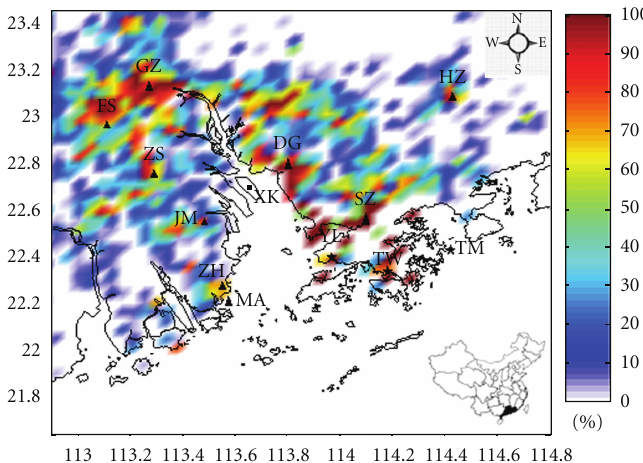
Figure 1: The geographic coverage of CMAQ model overlapped with urban density fraction (scaled from 0% to 100%) over Pearl River Delta region, China. (cid:2) represents the locations of urban cities over this region, in which the star sites Yuen Long (YL), Tsuen Wan (TW) and Tap Mum (TM) are there ambient air quality monitoring stations in Hong Kong with hourly continuous observation data for criteria pollutants. (cid:3) represents the location of Xinken (XK)